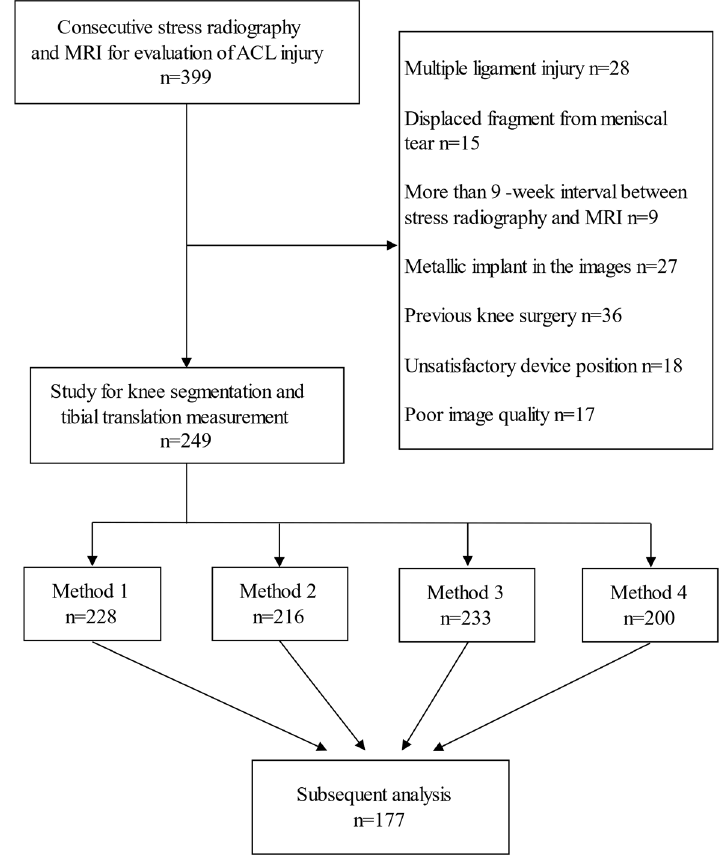
Figure 1. The flow chart of patient inclusion and exclusion.